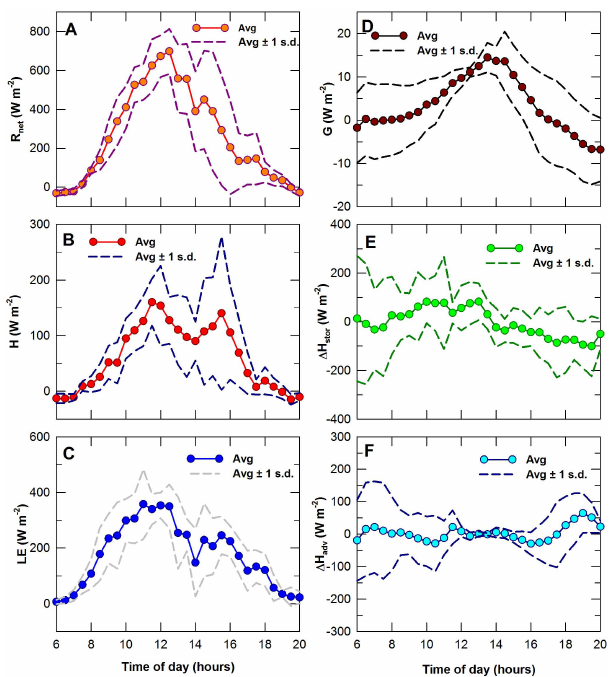
Fig. 6. Diurnal average ± 1 standard deviation (s.d.) of net radiation ( R net ; A ), sensible ( H ; B ) and latent (LE; C ) heat fluxes, soil heat flux adjacent to the tower ( G ; D ), change in enthalpy in the water column ( 1H stor ; E ), and that attributed to tidal inflows and outflows ( 1H adv ; F ) during 6–16 August 2005.